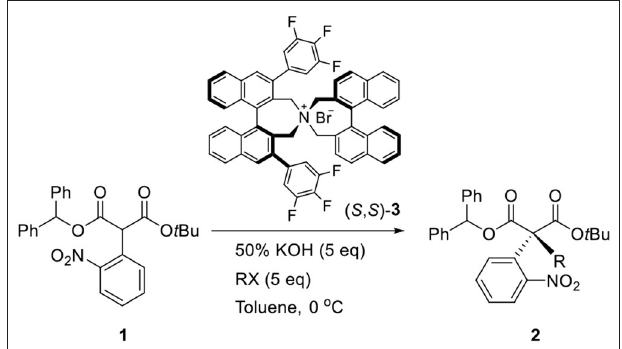
SCHEME 1 | Enantioselective PTC α -alkylation of malonate.